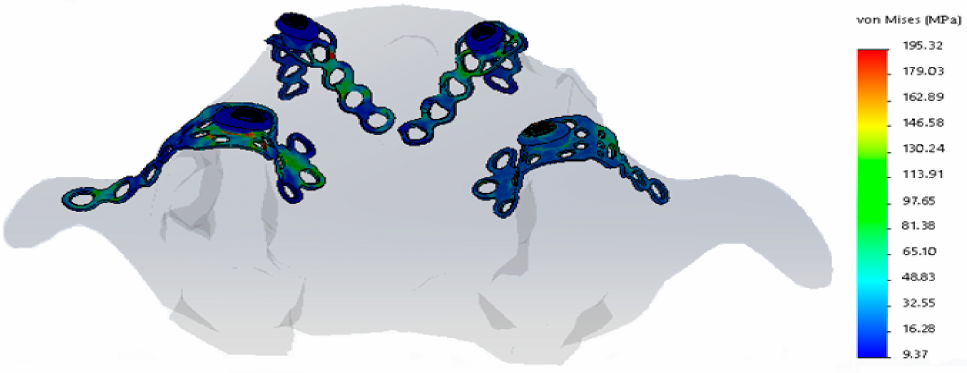
Figure 9. The von Mises stress on plates in